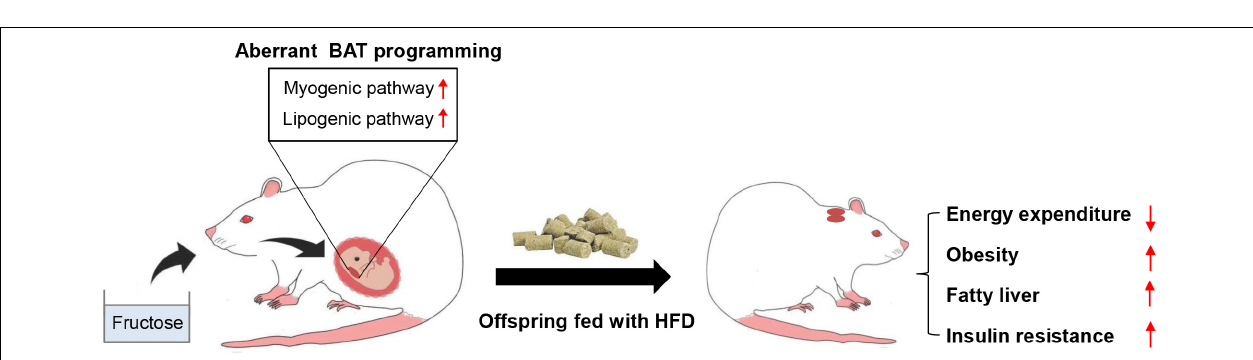
FIGURE 6 | Brown adipose tissue myogenic programming can be acutely induced by fructose administration. (A) The blood glucose level in fetuses at E18.5 ( n = 15–23). (B) The relative level of plasma fructose in fetuses at E18.5 ( n = 6). (C) qRT-PCR analysis of Glut4 and Glut5 expression in BAT of fetuses at E18.5 ( n = 6). qRT-PCR analysis of lipogenic genes (D) , myogenic genes (E) , and thermogenic genes (F) in BAT of mice gavaged with fructose or water ( n = 4–6). * p < 0.05, ** p < 0.01, *** p < 0.001.